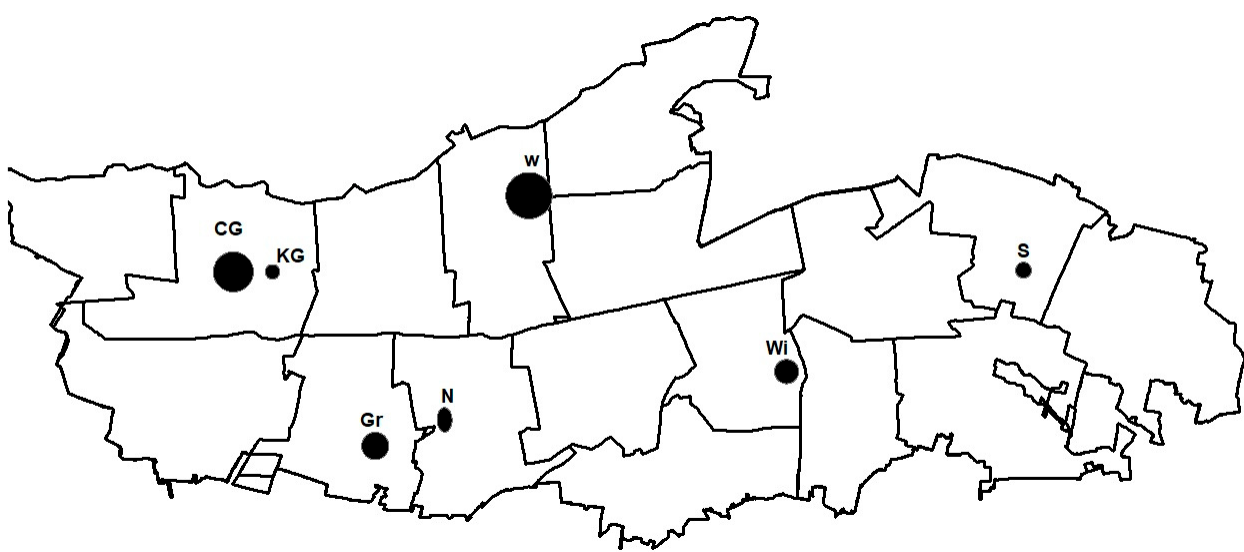
Figure 1. Location of the studied stands in the Kampinos NP area. Points mark survey locations based on their area according to the outermost sampled trees. The size of the marked point is based on the differences in the plots. Description according to the abbreviations used.